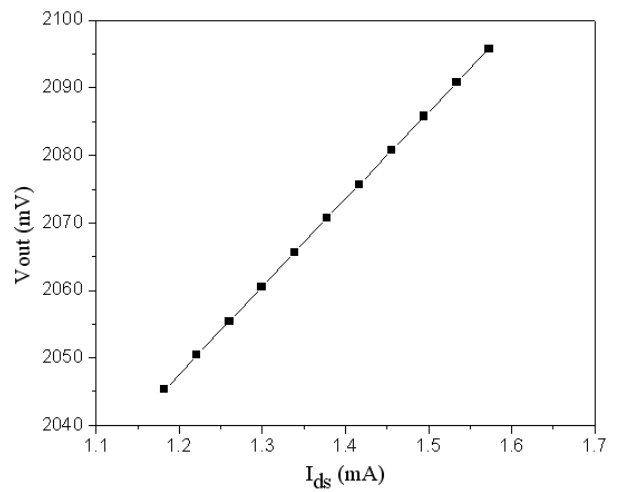
Figure 7. Output voltage of the amplifier.